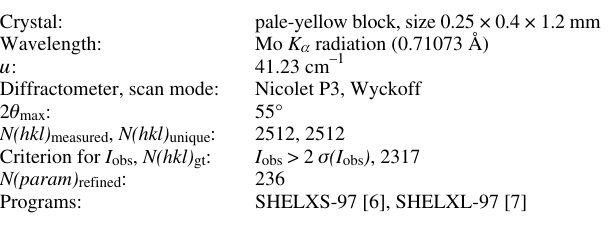
Table 1. Data collection and handling.